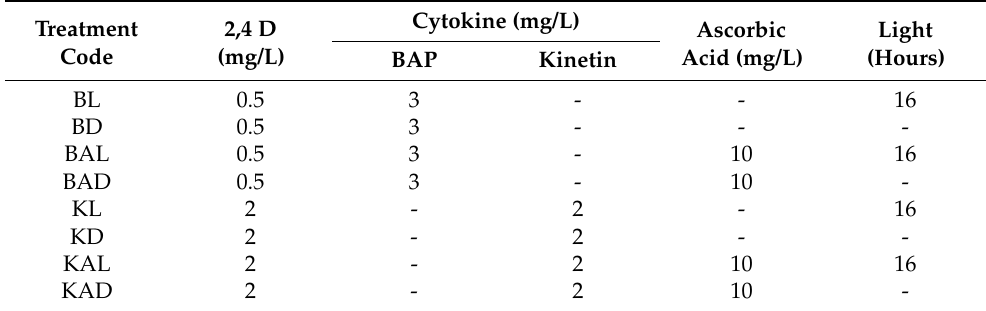
Table 3. Different concentrations of PGRs and ascorbic acid in culture media and culture conditions for the optimization of callus